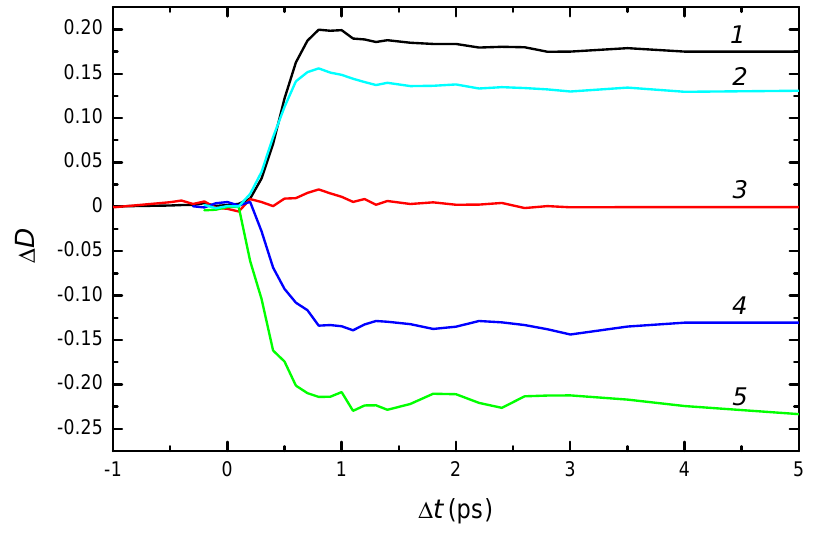
Figure 8. Kinetics of photoinduced time-resolved changes in the absorption spectrum of CdF :Ga ( N = 4 × 10 17 cm − 3 ) crystal under the impact of 150-femtosecond laser pulses 2 Ga with wavelength of 395 nm at room temperature. Probe wavelengths are curve 1 : 1000 nm; curve 2 : 850 nm and curve 3 : 530 nm.